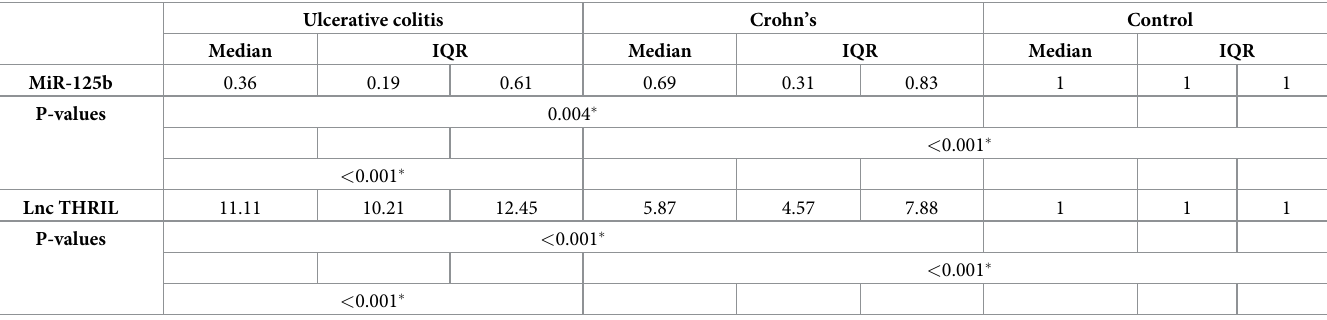
Table 2. Description of fold change of MiR-125b and Lnc THRIL among study